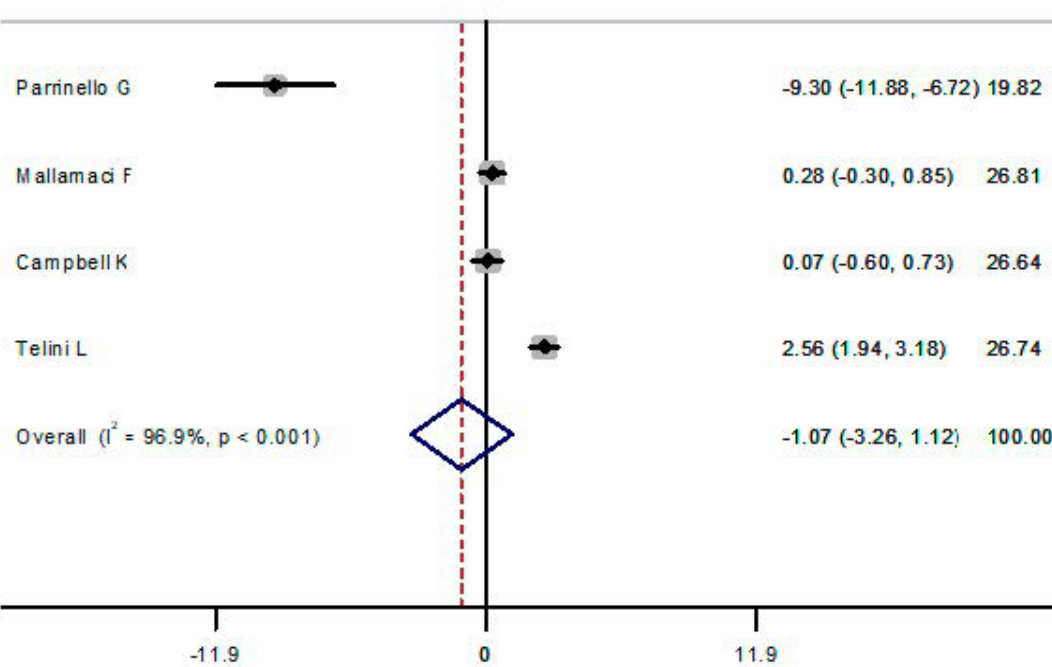
Figure 5. Forest plot of the mean difference in IL-6 levels for high sodium dose (HSD) versus low sodium dose (LSD) as defined per study [27,37,40,42].